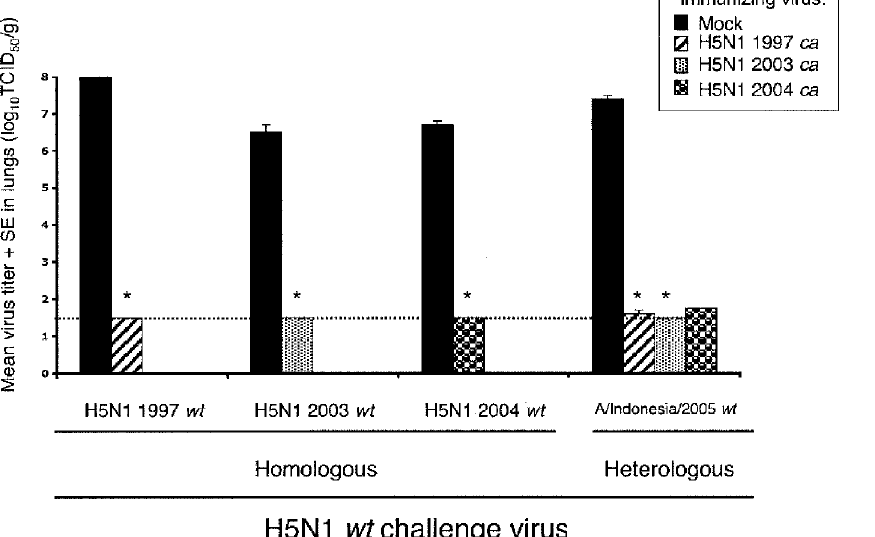
Figure 4. Immunization of Mice with Two Doses of H5N1 ca Viruses Provides Protection against Replication of Homologous and Heterologous H5N1 wt Viruses in the Lungs Mice that received two doses of 10 6 TCID 50 of H5N1 1997 ca, H5N1 2003 ca, or H5N1 2004 ca viruses 4 wk apart were challenged on day 56 p.i. with 10 5 TCID 50 of homologous and heterologous H5N1 wt viruses, including A/Indonesia/05/2005, a clade 2 H5N1 wt virus. The lungs were harvested from these mice 4 d later and were homogenized and titered on MDCK cells. Four mice were evaluated in each group. The lower limit of detection is indicated by the dashed horizontal line. * p , 0.02 compared to mock-immunized mice. DOI: 10.1371/journal.pmed.0030360.g004